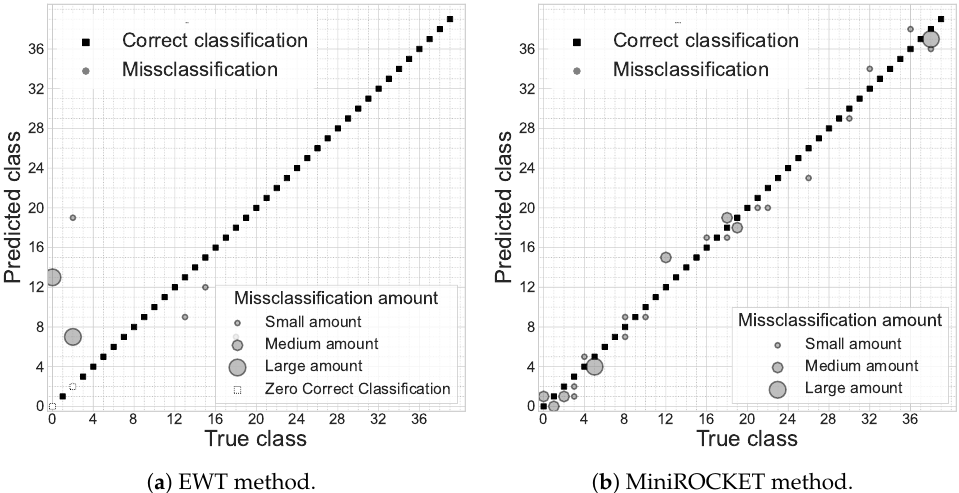
Figure 5. Confusion plots for the best results for EWT-based ( a ) and MiniROCKET-based ( b ) approaches; medium amount ∈ [ 100,600 ) ; large amount ∈ [ 600,1250 )